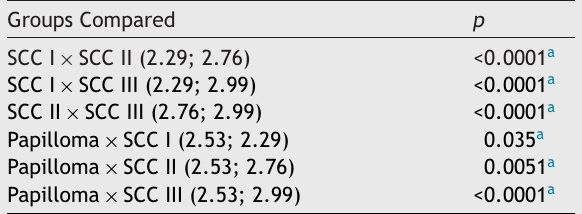
Means of total number of